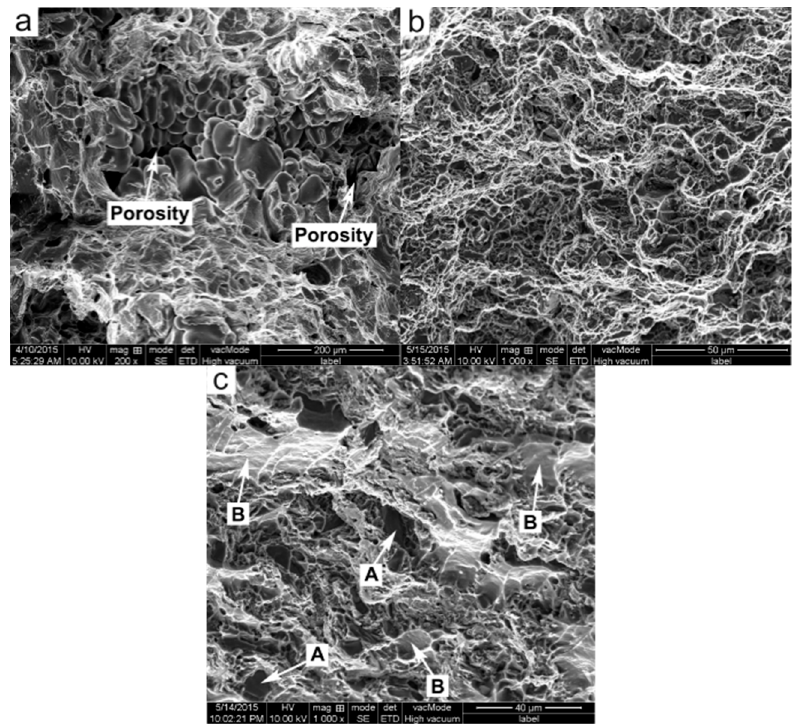
Figure 6. SEM fractographs of: ( a ) PMC-6061 alloy; ( b ) PTF-6061 alloy; ( c ) PTF-SiCp/6061Al composite.